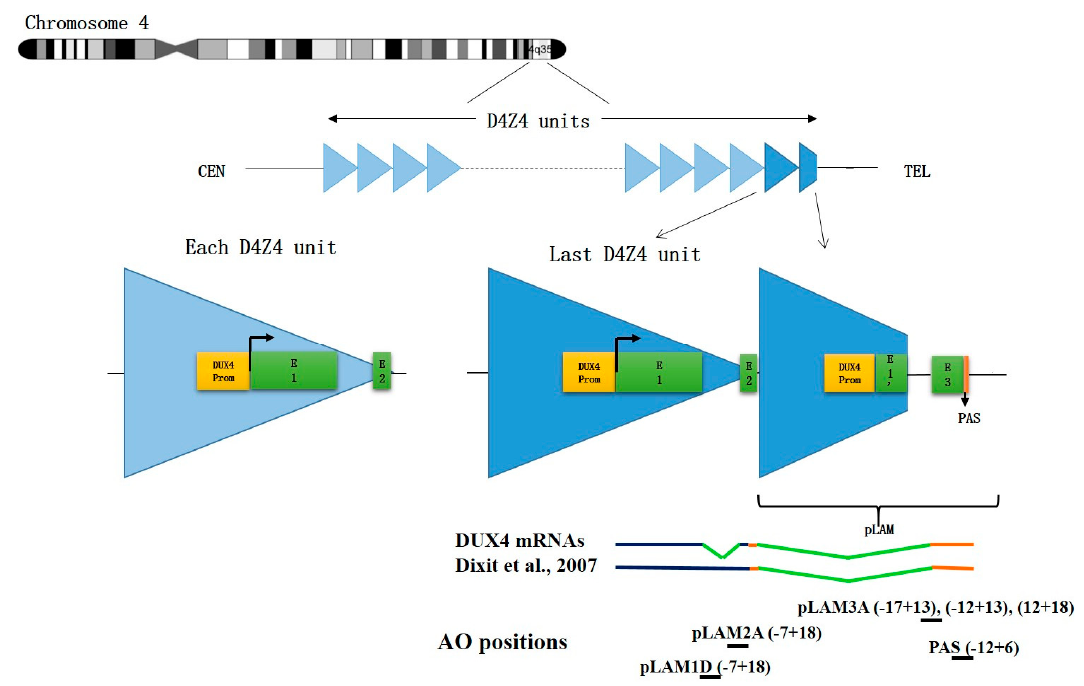
Figure 2. D4Z4 repeat array on chromosome 4 and antisense oligonucleotide positions. Top: Each D4Z4 repeated unit contains a promoter and an open reading frame (ORF) for DUX4 in the first exon (E1) and a short non-coding exon 2 (E2). On a 4qA permissive allele, the last D4Z4 unit is extended by a pLAM region providing intron I, an untranslated exon 3 (E3) and a polyadenylation signal (PAS) allowing for DUX4 mRNA stabilization and subsequent translation in DUX4 protein. Healthy individuals present 11–100 D4Z4 units while patients with FSHD1 only have 1–10 units. Bottom: Positions of the antisense oligonucleotides (AOs) described in this review. They are all designed for splicing interference except for PAS that affects mRNA polyadenylation.